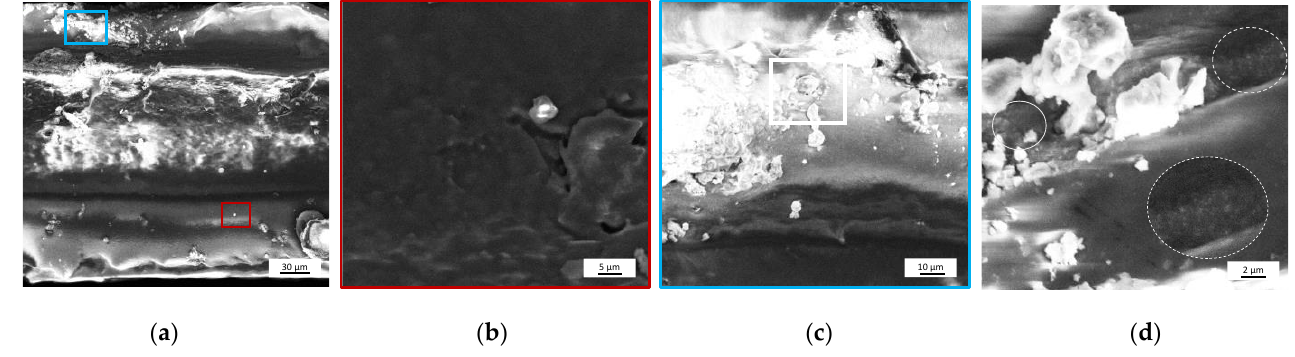
Figure 4. SEM images of ( a ) F2Ag sample cross-section, corresponding ( b ) higher magnification of the area highlighted in red, ( c ) higher magnification of the area highlighted in blue and ( d ) zoomed area of image ( c ).